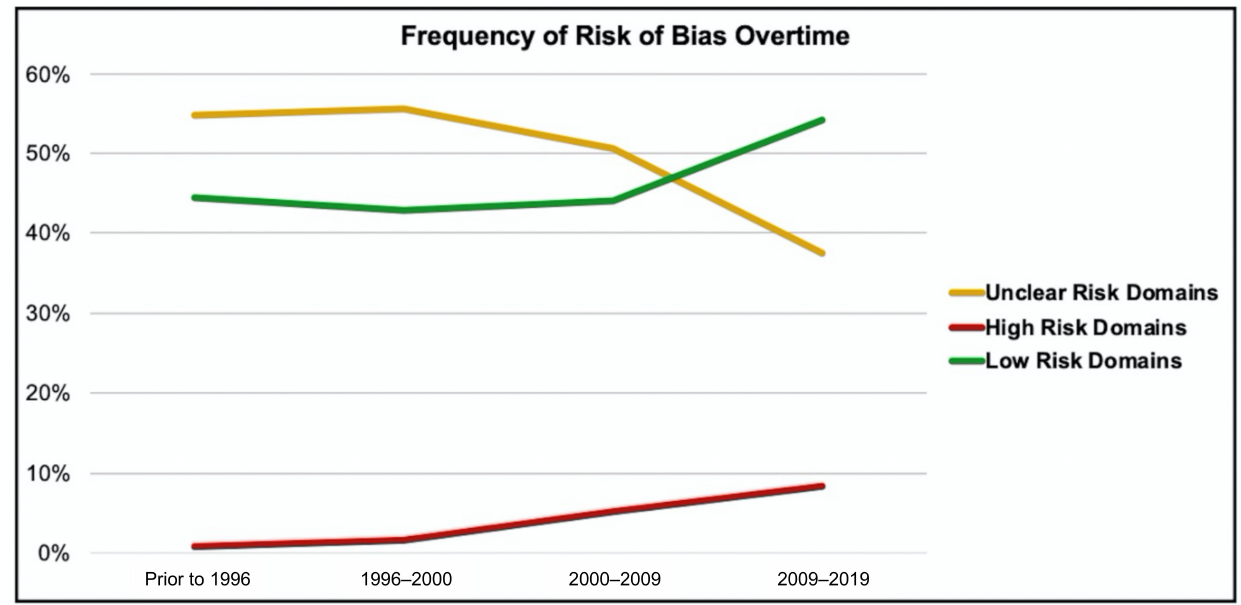
Figure 5. Frequency of risk of bias